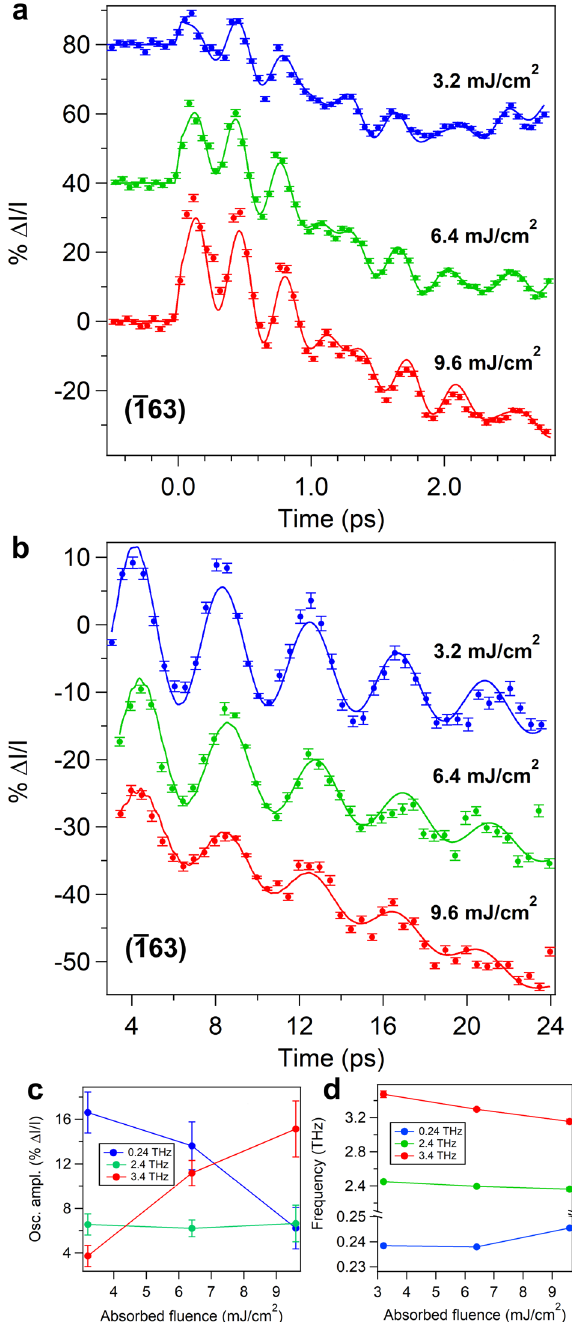
Fig. 3 Fluence dependence for the ð 163 Þ peak. a , b Experimental data and fi t curves for two time ranges, where the traces have been equally shifted for clarity; the oscillatory amplitudes and frequencies are reported in panels c and d . The error bars represent one standard deviation uncertainty.